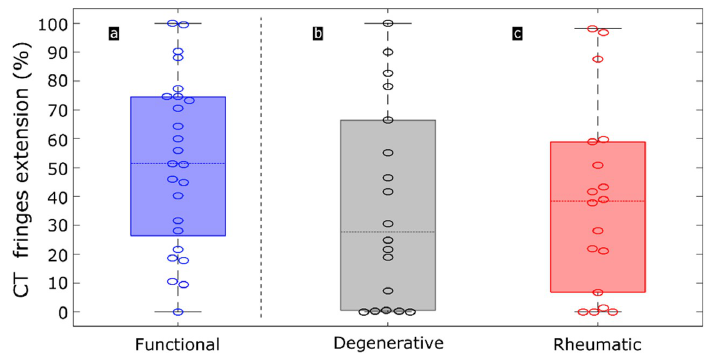
Figure 5. Boxplots representing the extension of periodic fringes along CTs of the three categories: functional (blue), degenerative (grey) and rheumatic (red). Extension is computed as a percentage of the B-scan length with A-scans exhibiting fringes. Dashed horizontal lines represent median of each category, this is, half of the observations is situated above this line and the other half is situated below this line. Boxes represent variation within 25% to 75% percentile. Black lines represent 5% to 95% of observations. Circles represent individual CTs.